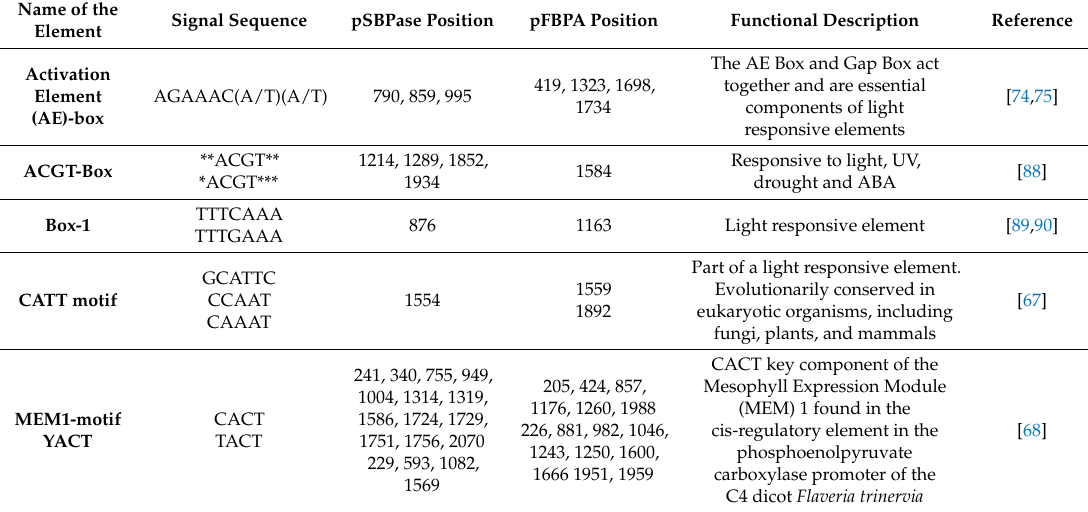
Table 1. Cis-acting elements analysis of 5 (cid:48) -upstream regulatory elements and their positions in the B. distachyon SBPase and FBPA promoters identified by PLANTCARE and literature